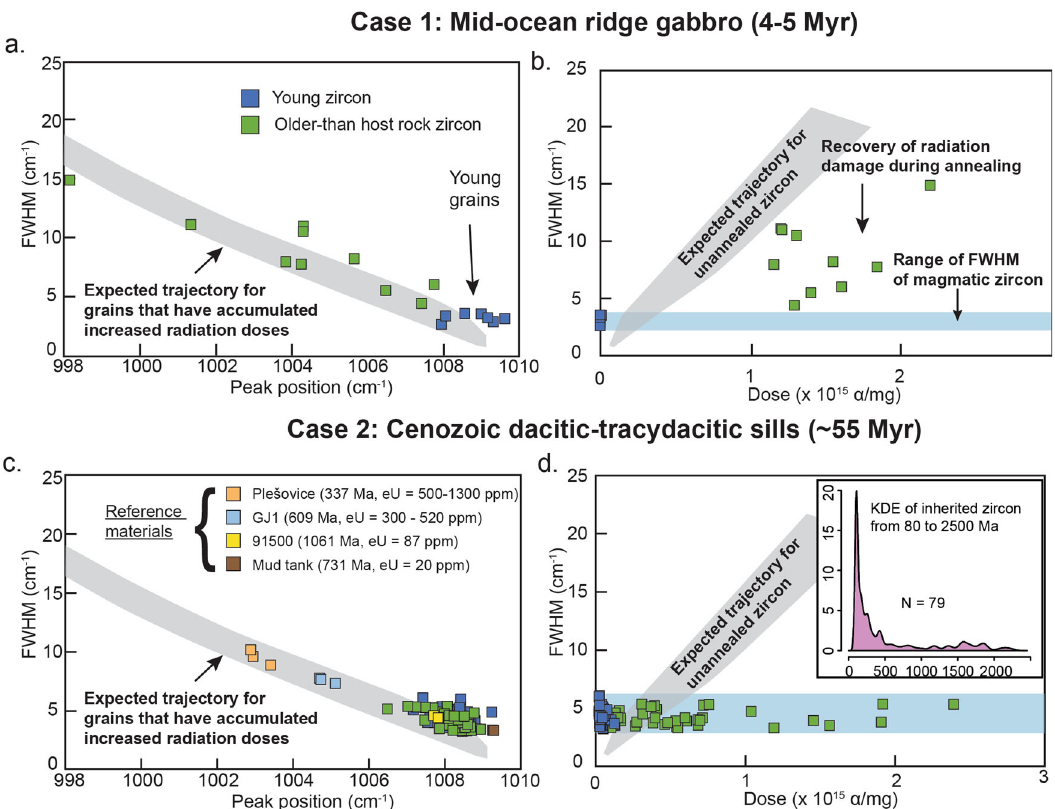
Fig. 3 Evaluation of radiation damage of single zircon grains. a , c The full width at half maximum (FWHM) vs. peak position of the ν 3 (SiO 4 ) stretching band. The expected trajectory for grains that have accumulated increased radiation doses is from Geisler et al. 30 . b , d FWHM vs. α -dose for young and inherited zircon grains. Data for unannealed zircon from Nasdala 28 . The vertical axis on the inset in d is based on histograms with a bandwidth of 40 Ma. Note that the young and old zircon grains in case 1 (mid-ocean ridge gabbro) plot at different locations in FWHM vs. peak position space while both young and older zircon in case 2 (Cenozoic sills) overlap.